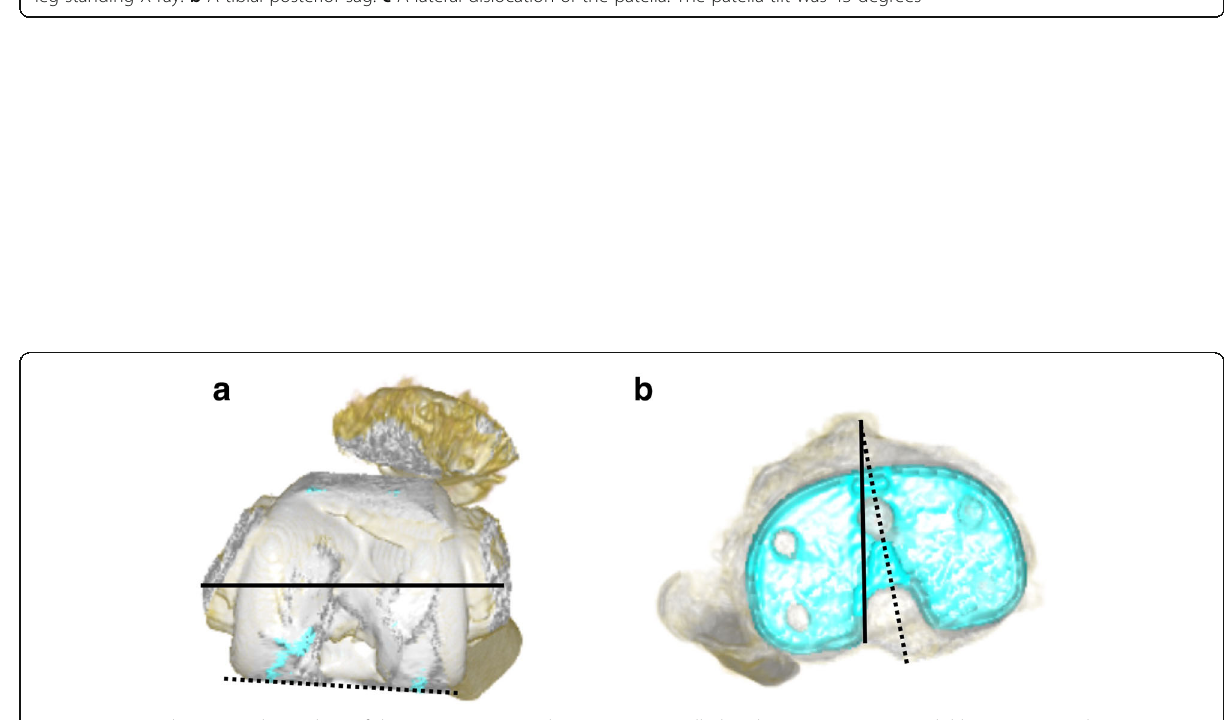
Fig. 2 X-rays of the patient ’ s knee at admission. a Mal-positioning of the femoral component by as much as 18 degrees was evident in a long leg standing X-ray. b A tibial posterior sag. c A lateral dislocation of the patella. The patella tilt was 43